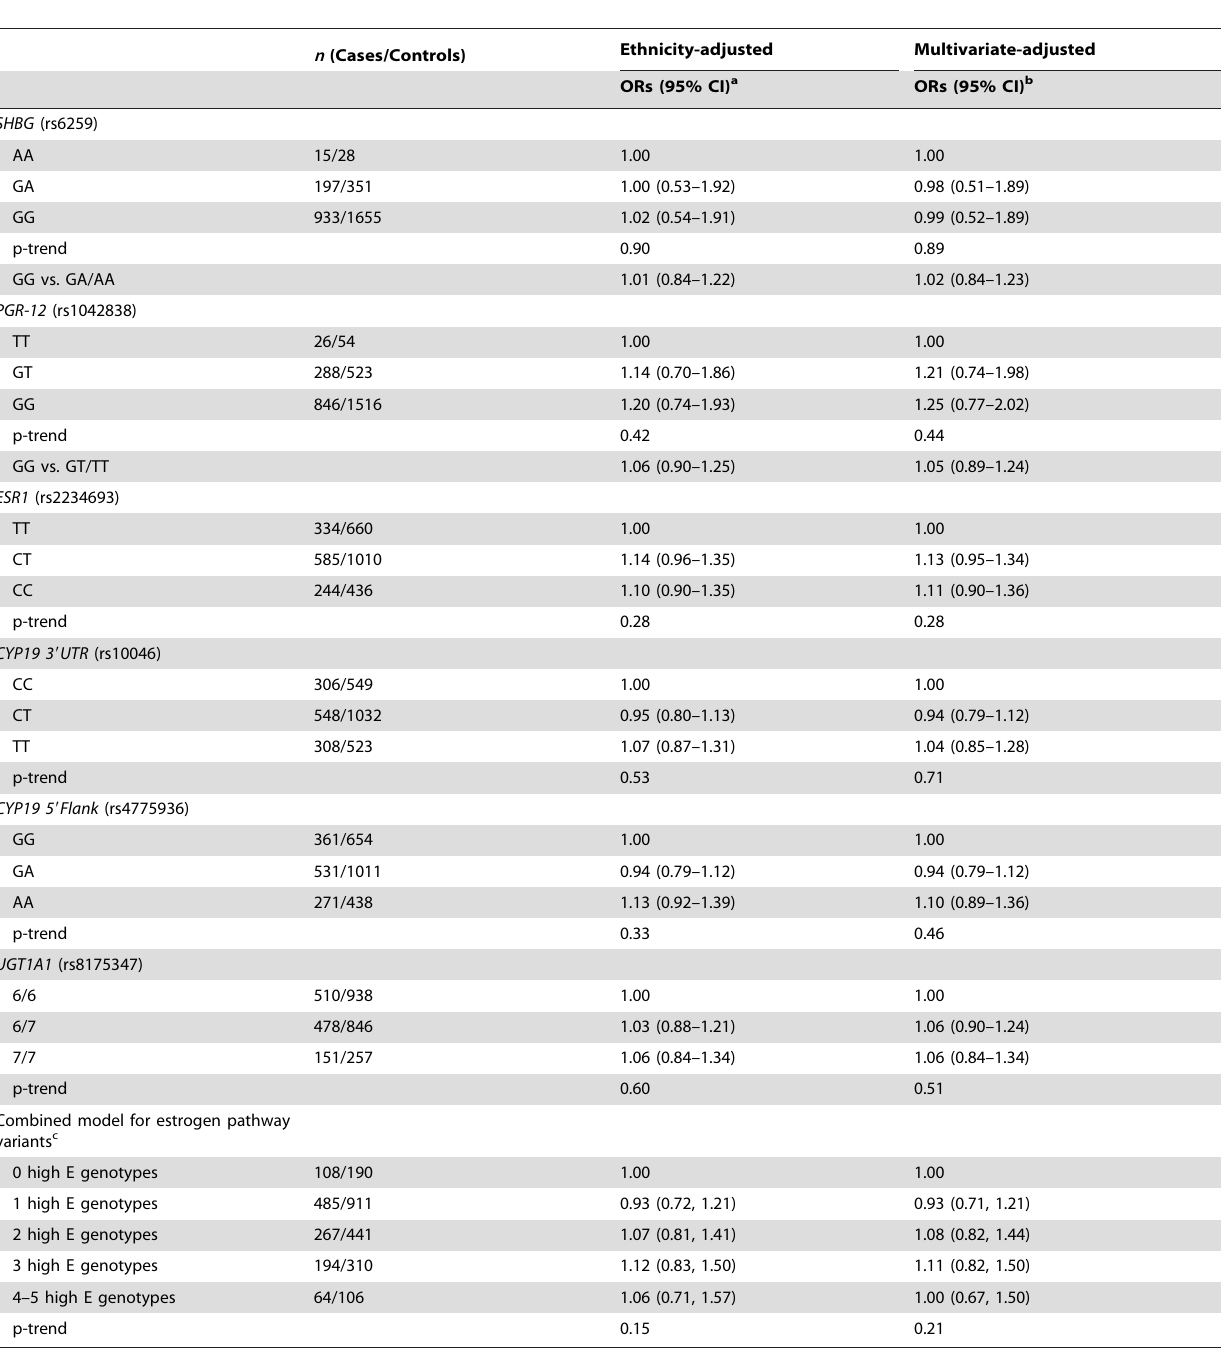
Table 2. Associations between genetic variants in hormone-related genes and breast cancer risk in pre- and post-menopausal